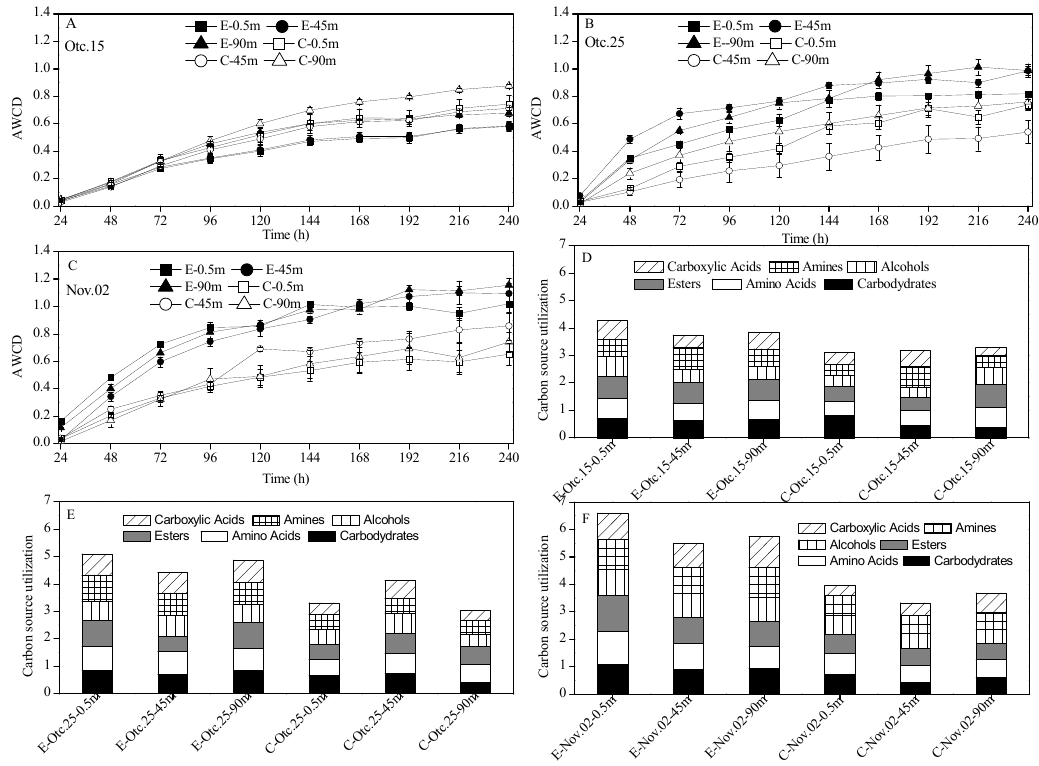
Figure 3. AWCD and carbon source utilization variation of microbes in the enhanced and control areas during the operation of WLAs (( A , D ): 15 October, ( B , E ): 25 October, ( C , F ): 2 November; E—indicates “enhanced area”; C—indicates “control area”).